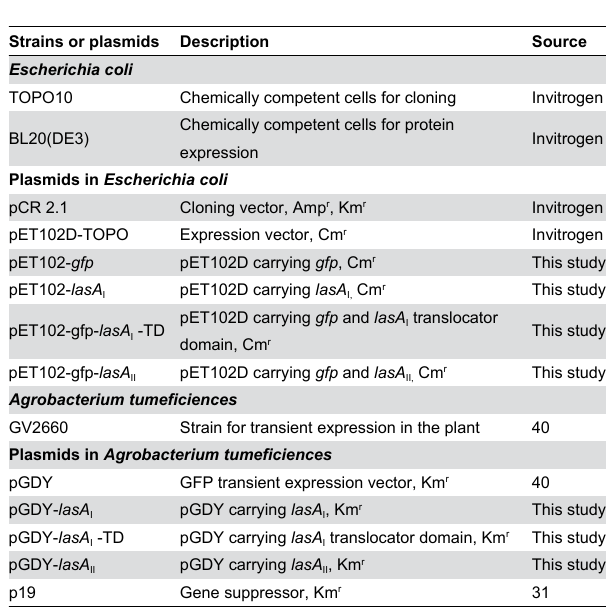
Table 1. Strains and plasmids used in this